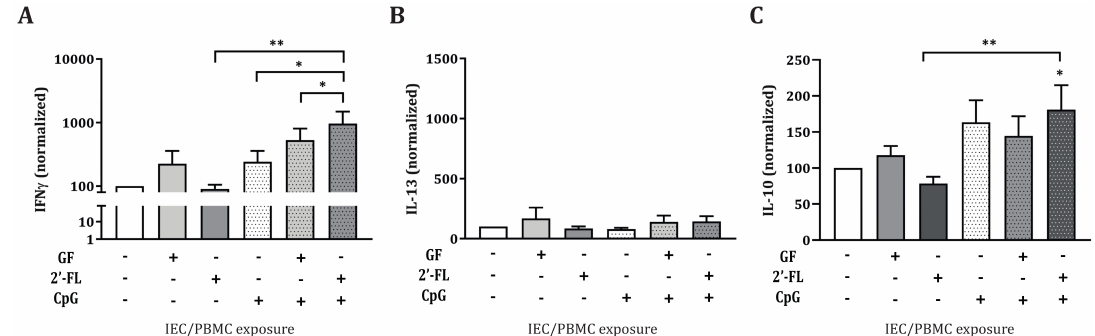
Figure 7. Cytokine secretion in ccDC / T-cell assay after moDC co-culture with conditioned IEC. Conditioned moDC (ccDC), previously exposed to conditioned IEC, were incubated with naïve T-cells for 5–6 days in an allogeneic ccDC / T-cell assay (Figure 1D). Afterwards, IFN γ ( A ), IL-13 ( B ) and IL-10 ( C ) were measured. Data were normalized per donor and represented as mean ± SEM from 5–12 independent PBMC donors (* p < 0.05, ** p <